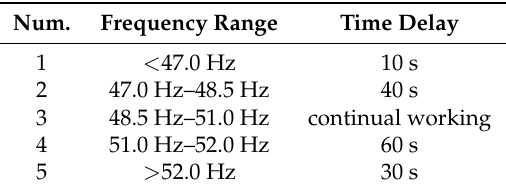
Table 1. Parameters of abnormal frequency